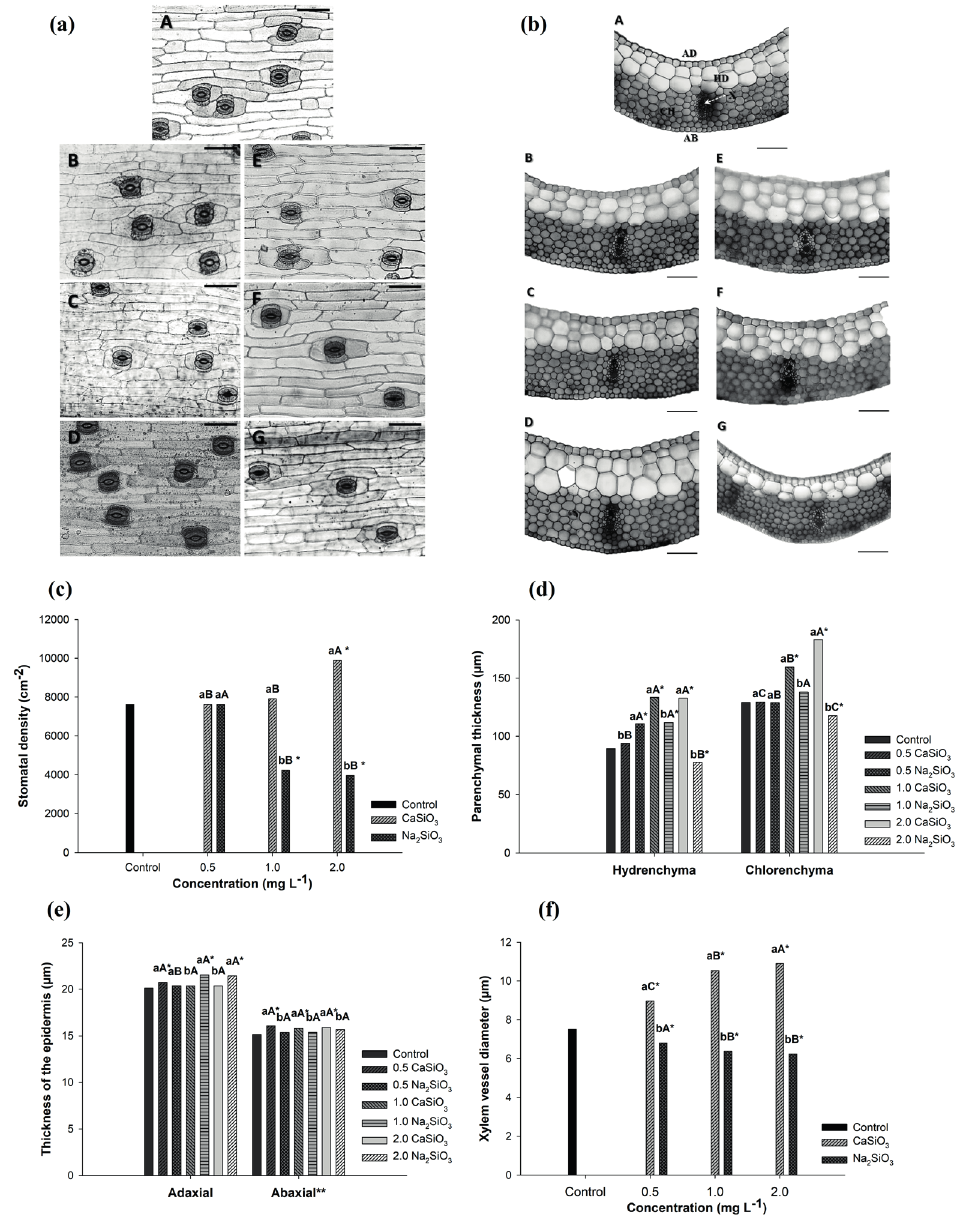
Figure 3 - Paradermal (a) , cross sections (b) , stomatal density (c) , thickness of the epidermis (d) , parenchymal thickness (e) and xylem vessel diameter (f) of B. zebrina leaves as a function of different sources and concentrations (mg L -1 ) of silicates after 100 day of in vitro growth. ( a-b ): (A) Control; (B-D) 0.5, 1.0 and 2.0 CaSiO mg L -1 , respectively; (E-G) 0.5, 1.0 and 2.0 Na SiO mg L -1 , respectively. Adaxial 3 2 3 epidermis (AD), abaxial epidermis (AB), hydrenchyma (HD), chlorenchyma (CH) and xylem (X). ( c-f ): means followed by ‘*’ are different from the control by Dunnet’s multiple range test at 5% probability; lowercase letters refer to the unfolding of the sources within each concentration; the means with distinct lowercase letters are different by Tukey’s multiple range test at 5% probability. Capital letters refer to the unfolding of concentrations within each source; the means with distinct capital letters are different by Tukey’s multiple range test at 5% probability. ‘**’ Indicate no significant statistical interaction between the sources and concentrations. Bars 50 μm (a) and 100 μm (b)